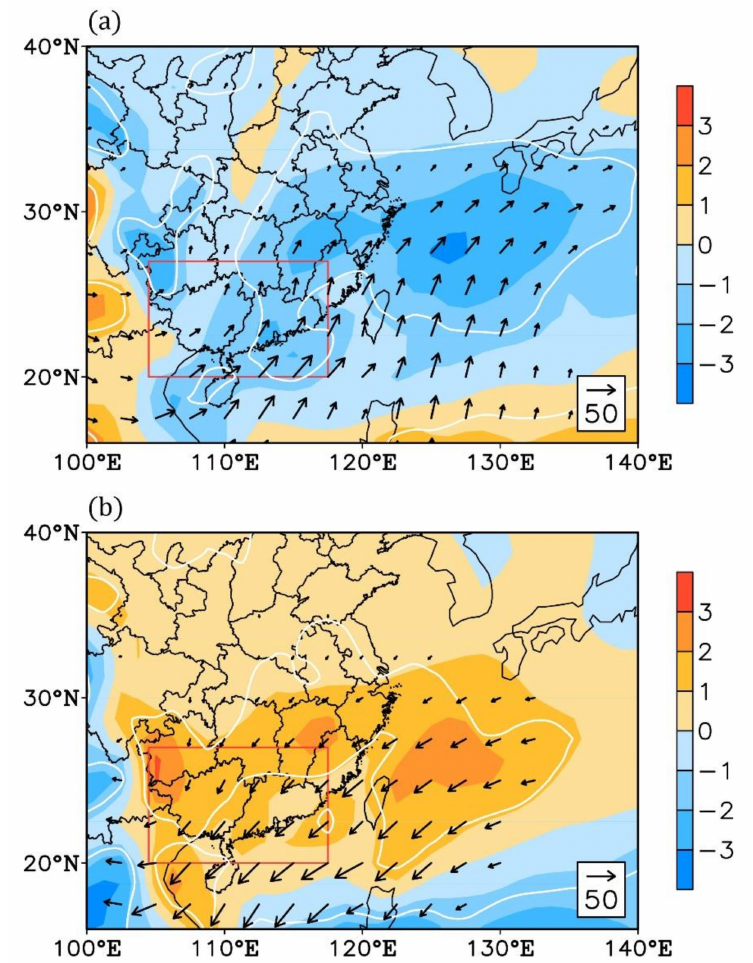
Figure 6. Composite anomalies of spring water vapor flux (arrows; units: kg m − 1 s − 1 ; only arrows significant with p < 0.1 are shown) integrated from 300 to 1000 hPa and its divergence (colors; units: 1 e 5 kg m − 2 s − 1 ; the areas within white lines are significant with p < 0.1) in the ( a ) El Niño cases and ( b ) La Niña cases. All data are linearly detrended. The red boxes denote the South China